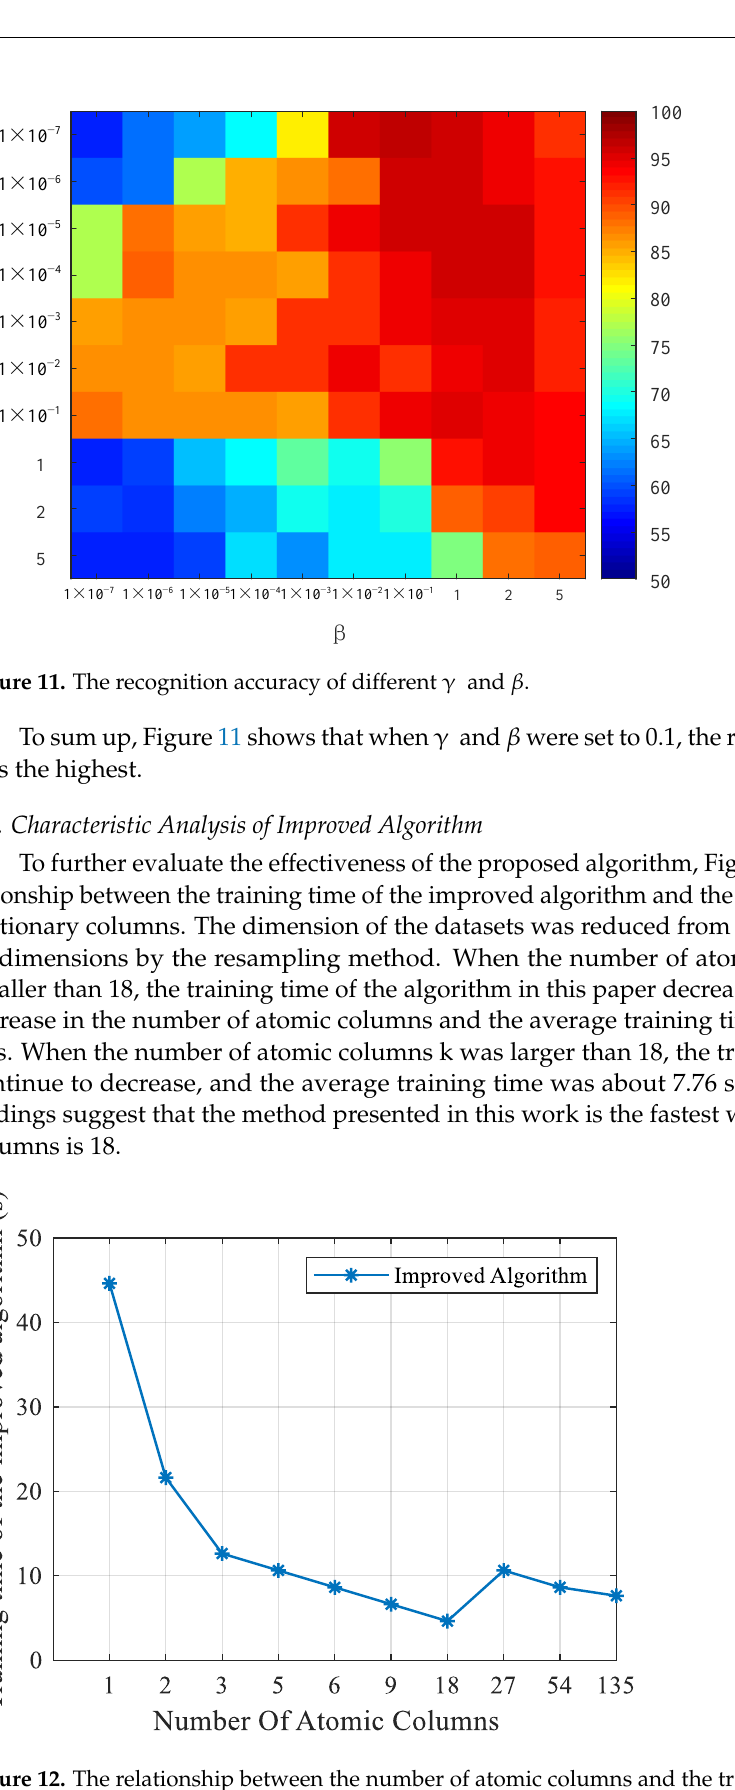
Figure 12. The relationship between the number of atomic columns and the training